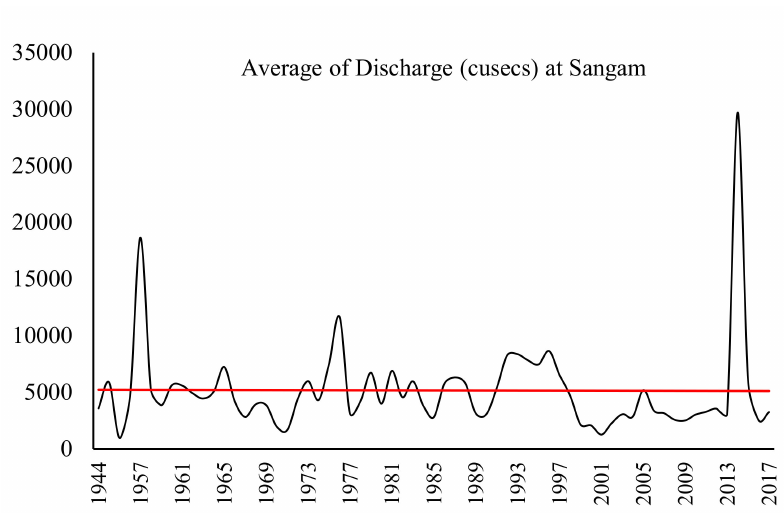
Figure 8. Annual average discharge at Sangam (Source: I&FC, Department).